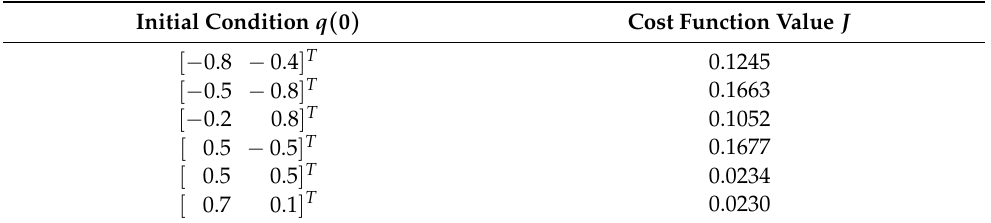
Table 2. The cost function values J of the proposed GCC design methodology with six different initial conditions in Example 2.